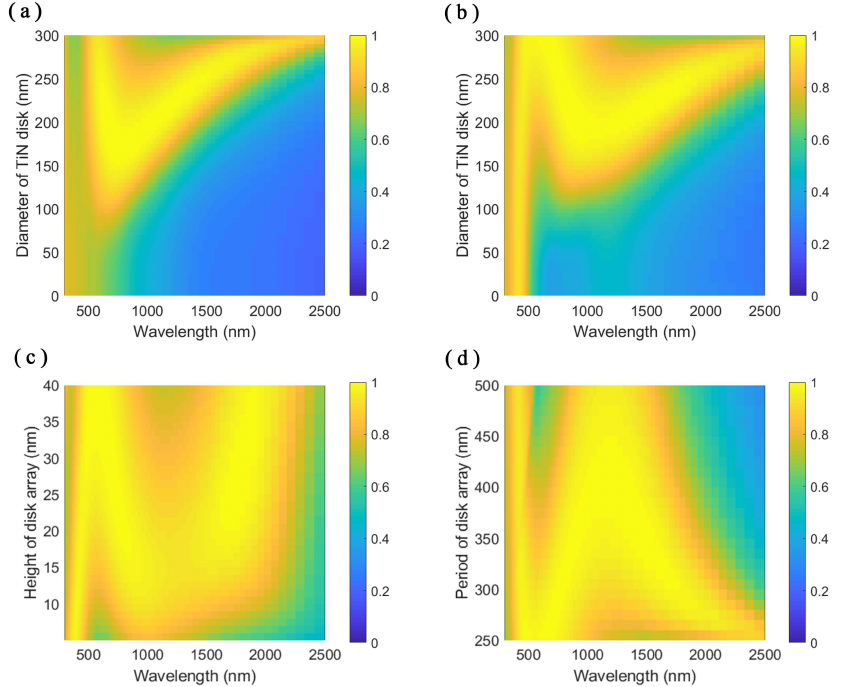
Figure 4. Absorption spectra with respect to the varying diameter of the nanodisk of: ( a ) patterned- TiN/SiO 2 /TiN stacks; and ( b ) SiO 2 /patterned-TiN/SiO 2 /TiN stacks. The height of the TiN nanodisk is 20 nm and the period of the nanodisk array is 300 nm. ( c ) Absorption spectra of the SiO 2 /patterned- TiN/SiO 2 /TiN stacks with respect to the varying height of the nanodisk. The diameter of the disk is 240 nm and the period of the array is 300 nm. ( d ) Absorption spectra of the SiO 2 /patterned- TiN/SiO 2 /TiN stacks with respect to the varying period of the nanodisk array. The diameter of the disk is 240 nm and the height of the disk is 20